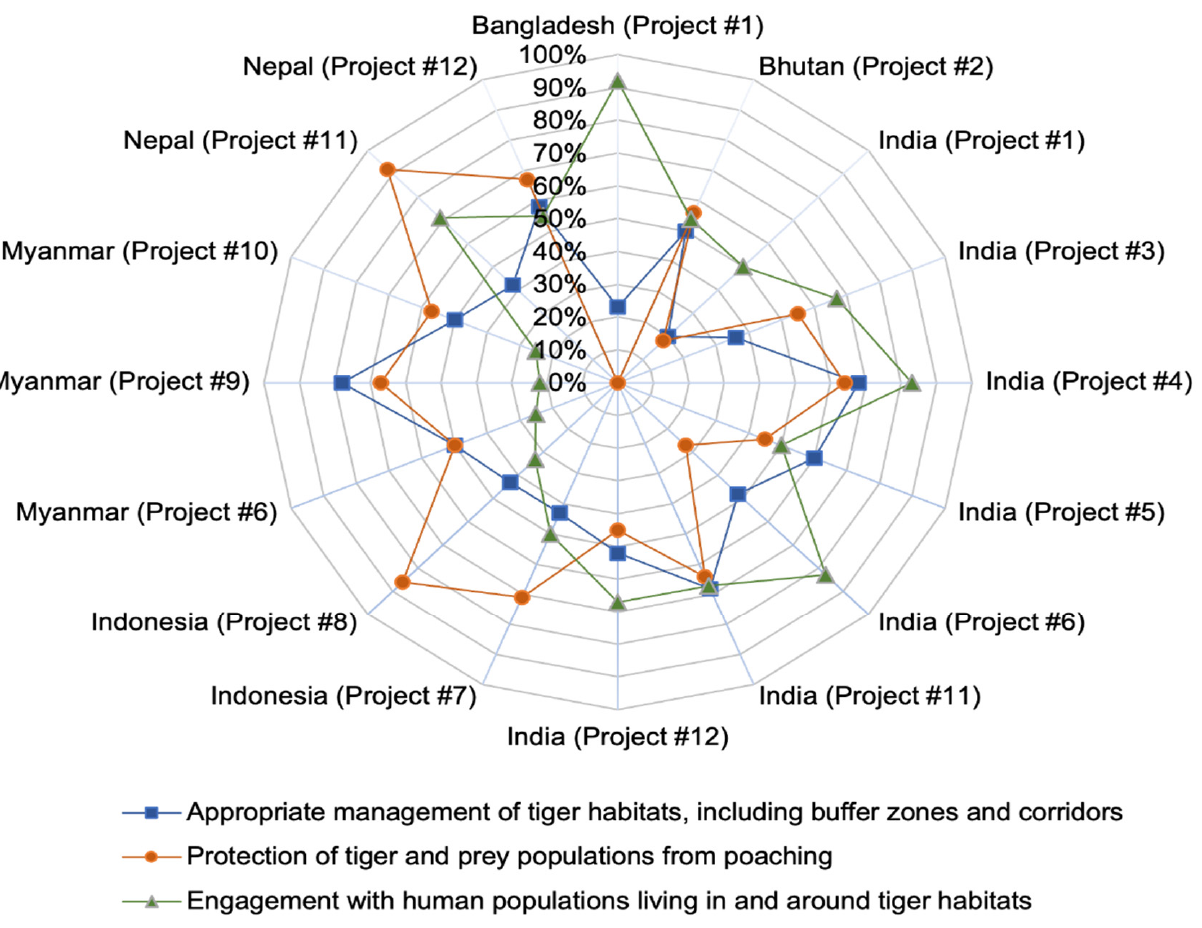
Figure 2. The extent to which ITHCP project proposals address the actions stated in their corresponding NTAPs that match with the ITHCP pillars.